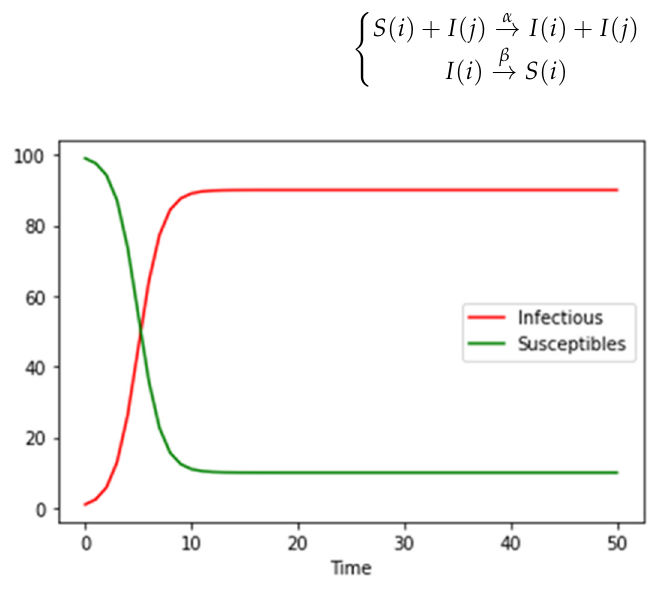
Figure 2. Diagram of the SIS model.